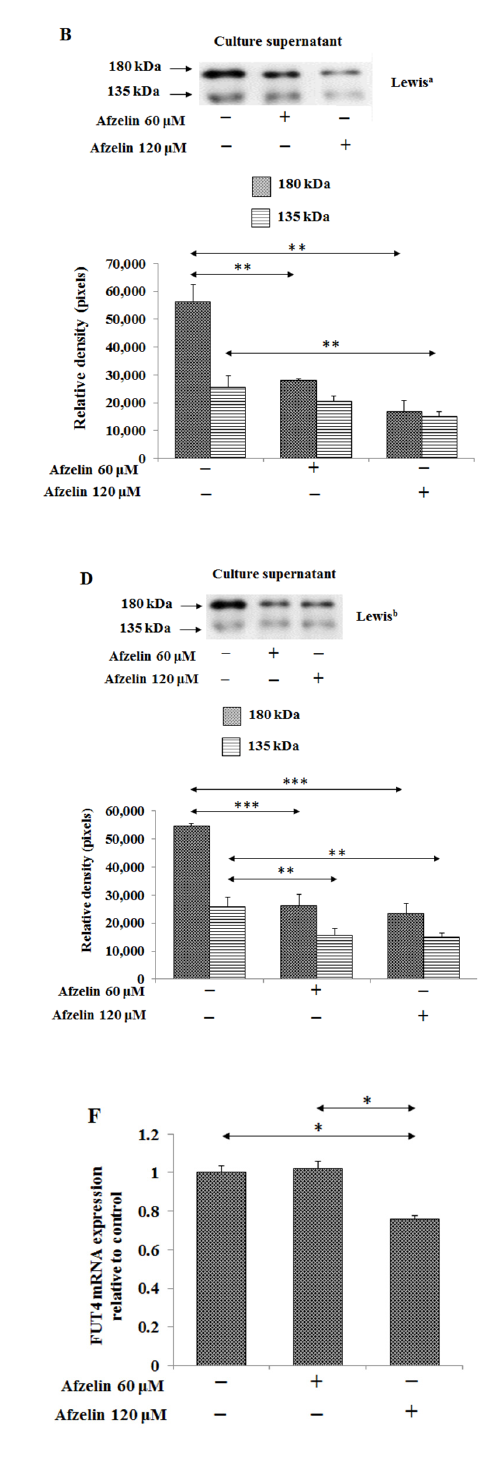
Figure 9. Effect of afzelin on Lewis a and Lewis b antigen expression as well as enzymes participating in these antigens’ formation in AGS gastric cancer cells treated with 60 and 120 μ M afzelin. Western blotting was used to determine Lewis a ( A , B ) and Lewis b ( C , D ) structures in cell lysates and culture medium. The β -actin expression served as protein loading control. The bands intensity was quantified by densitometry. Data are presented as the mean ± SD from 3 assays. * p ˂ 0.05; ** p ˂ 0.01; *** p ˂ 0.001. FUT3 ( E ) and FUT4 ( F ) gene expressions were assessed by RT-PCR. The results are shown as a relative fold change in FUT3 and FUT4 mRNA in comparison to control where expression was set as 1. ±SD are the mean of triplicate cultures. * p ˂ 0.05; *** p ˂ 0.001.